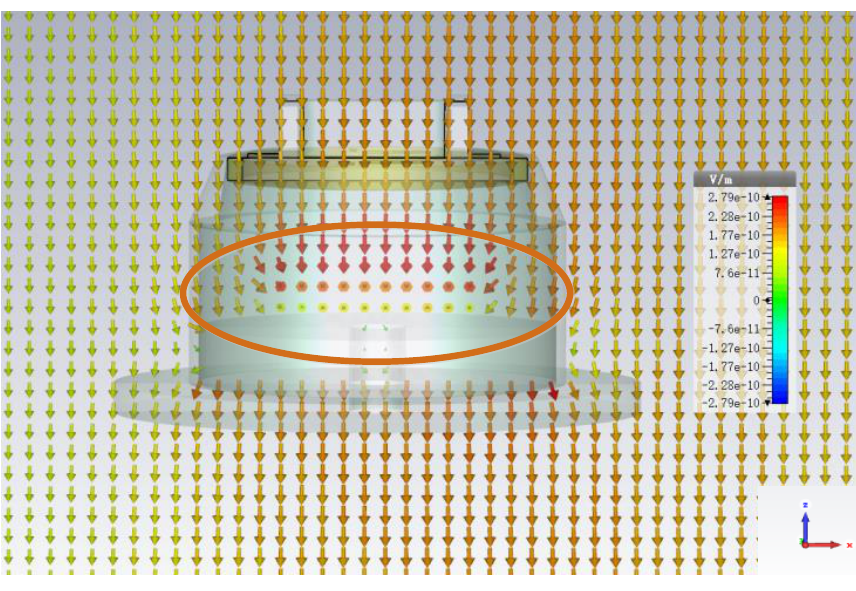
Figure 12. The structure of electromagnetic field.